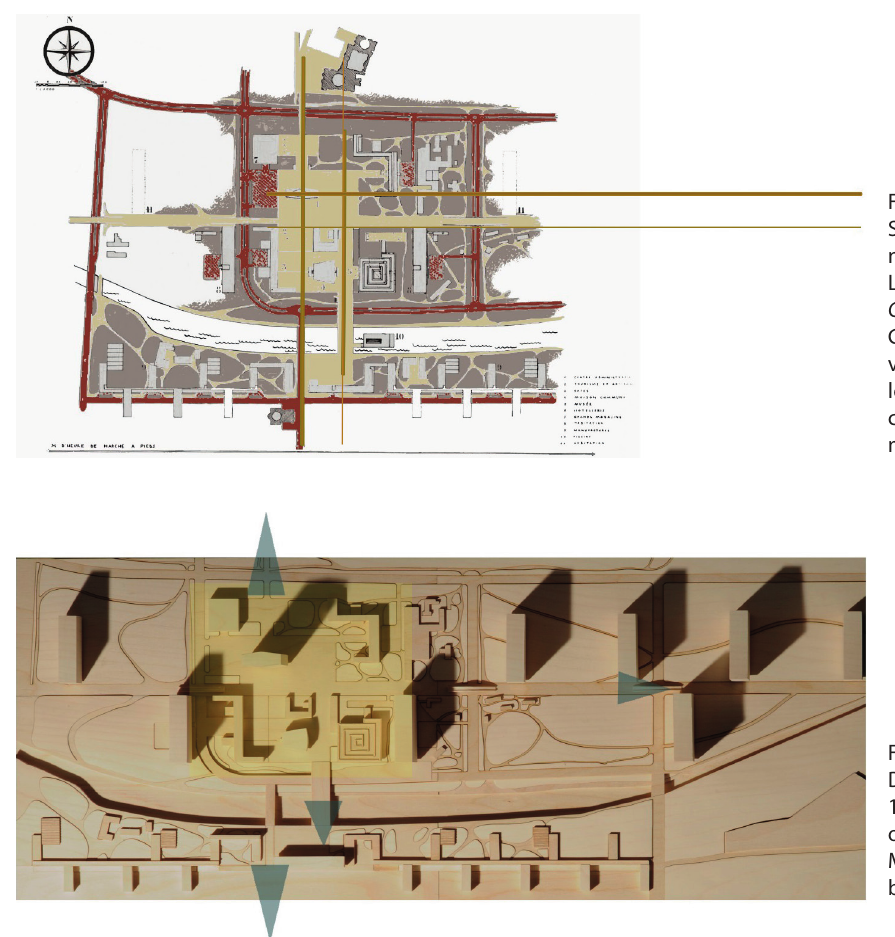
fig. 7. The civic centre of